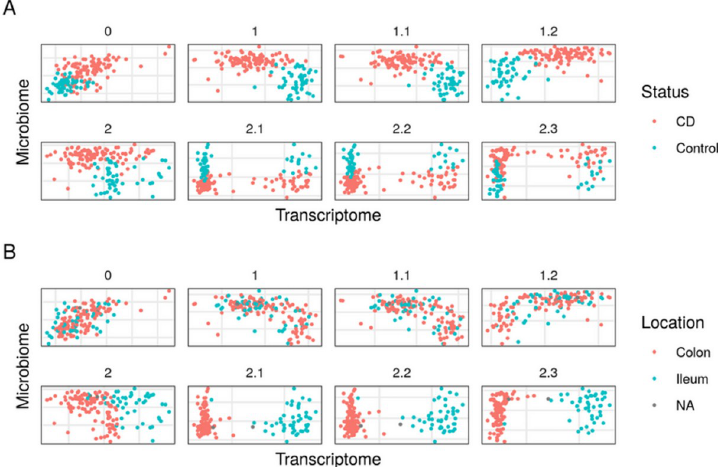
Fig 3. First dimensions of the host transcriptome and the microbiome block of models on the hematopoietic stem cell transplant Crohn’s disease dataset. Comparison of the models that better explained the interaction between the microbiome and the host transcriptome data on the HSCT CD dataset. Each point represents a sample (colored by disease status): A, non-CD (Control) or CD; and B, by location, colon or ileum, on the first components of the host transcriptome and the microbiome. Better models separate samples by tissue location by the host transcriptome component and the diseased and controls samples by the microbiome component.